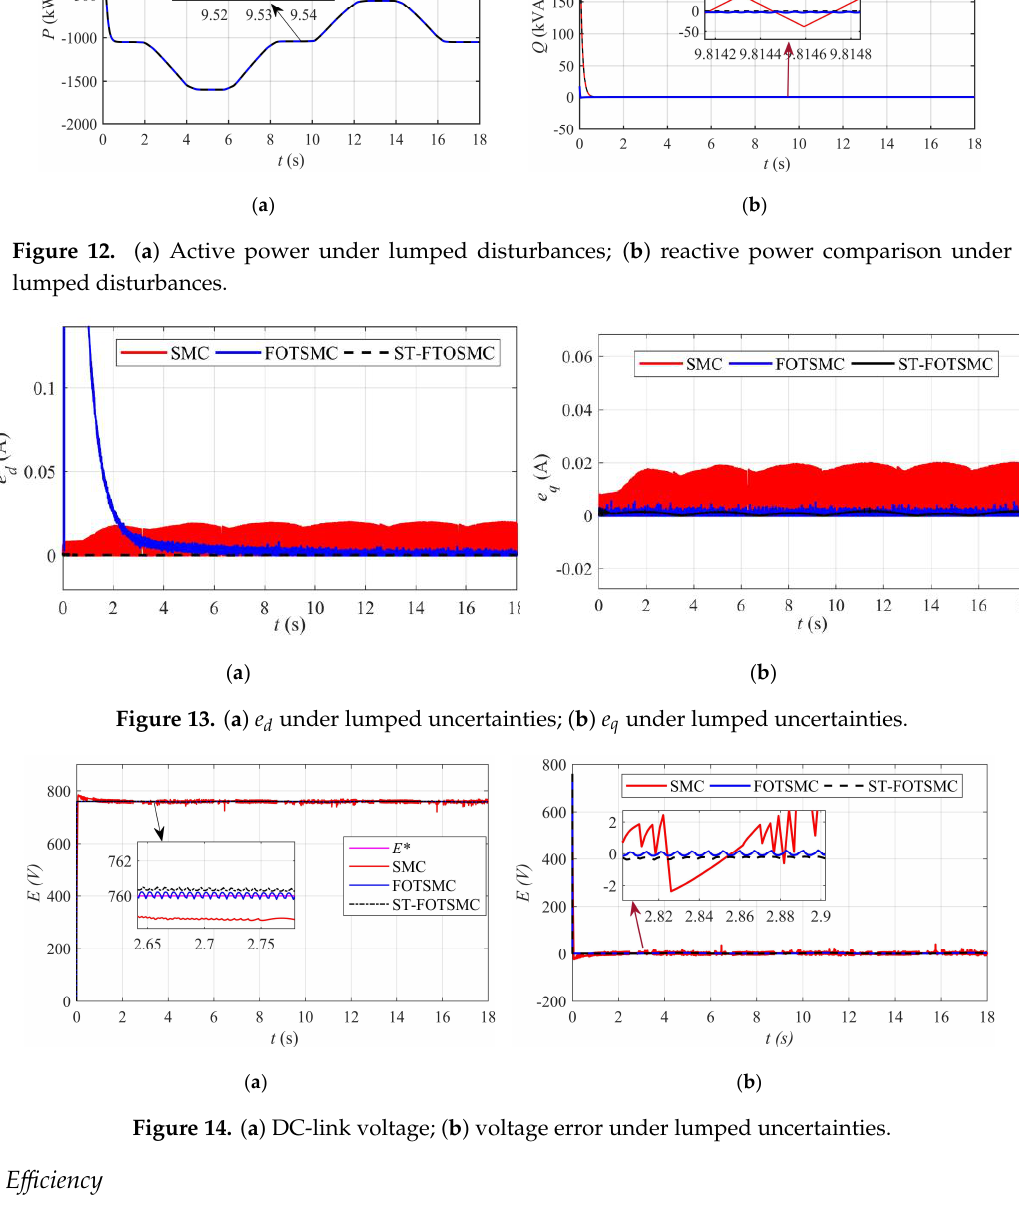
Figure 14. ( a ) DC-link voltage; ( b ) voltage error under lumped uncertainties.